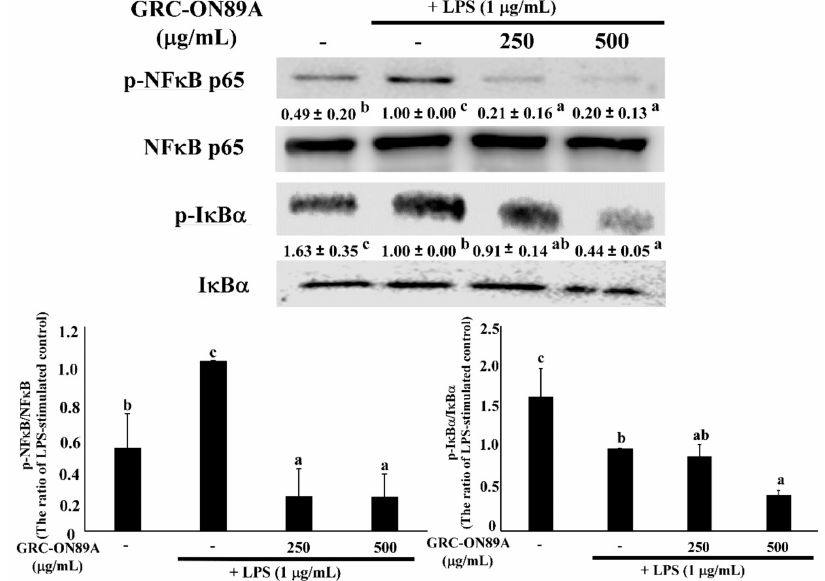
Figure 4. GRC-ON89A-Hex suppresses the phosphorylation of nuclear factor (NF)- κ B and I κ B α in LPS-stimulated RAW 264.7 macrophages. Macrophages were pre-incubated with GRC-ON89A-Hex for 12 h and then incubated with LPS (1 µ g/mL) for 20 min. One-way analysis of variance (ANOVA) was used for comparison of group means, followed by Duncan t -test. Different letters indicated that the differences between the groups are significant at p < 0.05. Data are expressed as means ± SD of independent experiments ( n ≥